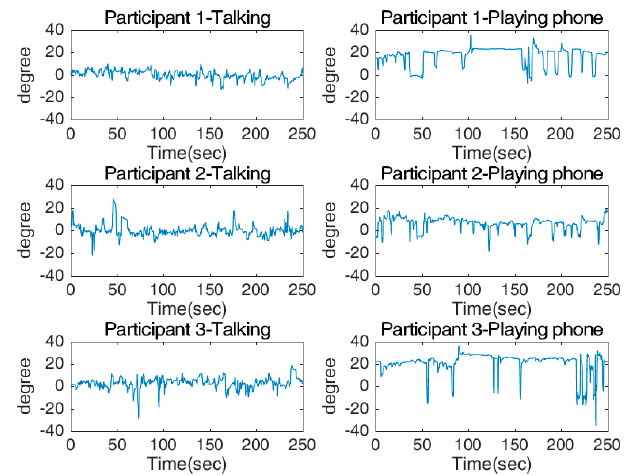
Figure 15. Measured nodding angles for two tasks: talking ( left column) and playing phone ( right column).